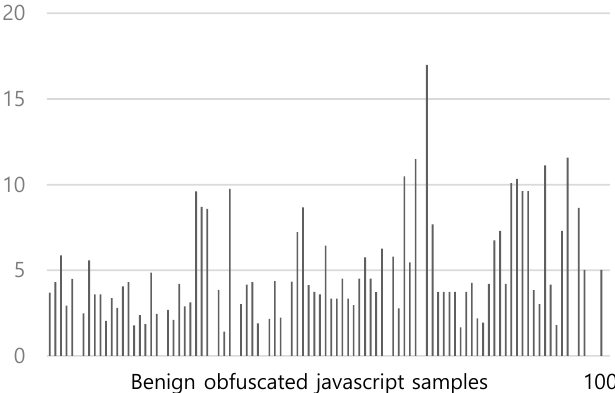
Figure 7. TF-IDF average values over redirection tokens in 100 obfuscated benign JavaScripts using the conventional TF-IDF.